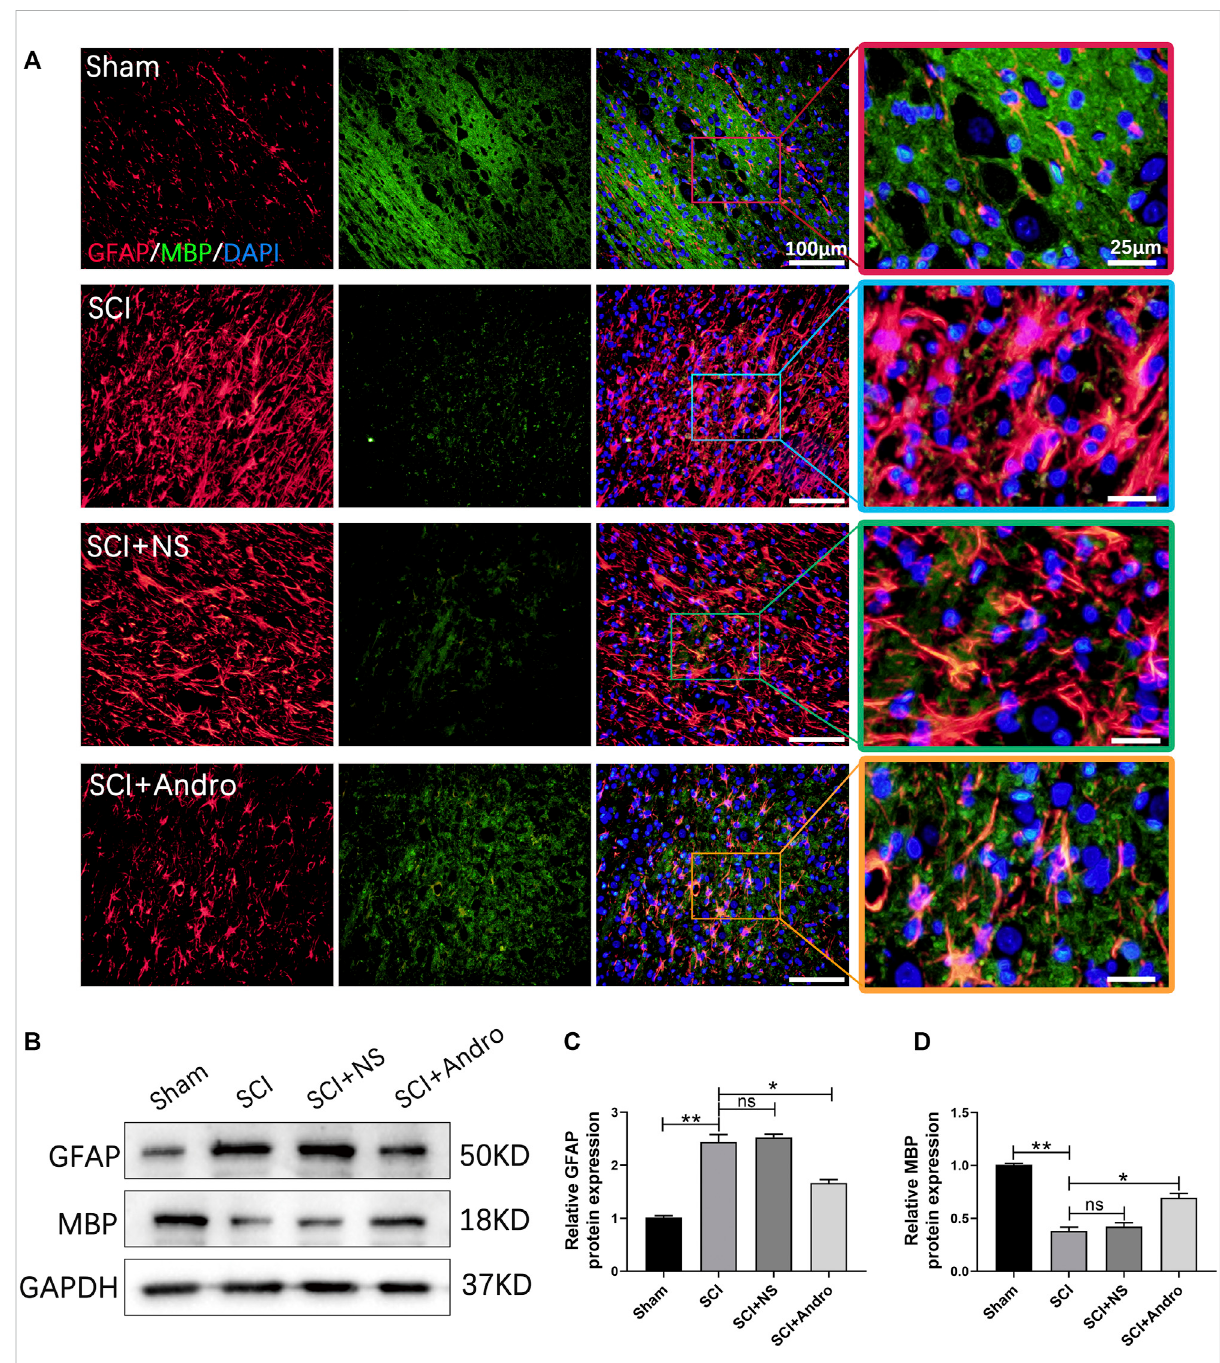
FIGURE 6 Andro treatment enhanced axonal remyelination in SCI rats. (A) Co-immuno fl uorescent staining showed the glial scar (GFAP, red) and the axonal remyelination (MBP, green) in spinal cord tissues 28 days post-SCI. (B – D) Immunoblot and relative quanti fi cation of GFAP and MBP proteins. Data are presented as the mean ± SD, n = 3 per group.* p < 0.05,** p < 0.01, ns p ＞